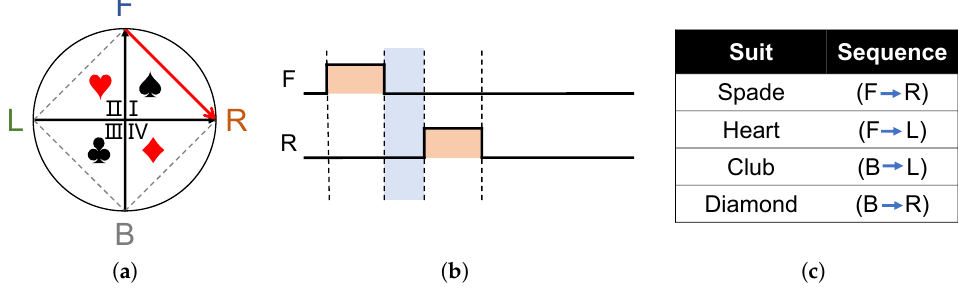
Figure 4. Poker stereoscopic perceptual suit coding, taking spades suit coding FR as an example. ( a ) The neck ring consists of four quadrants with pairwise motors and their corresponding patterns. ( b ) Motor timing diagram corresponding to spades code. ( c ) The poker suit code corresponding to the neck